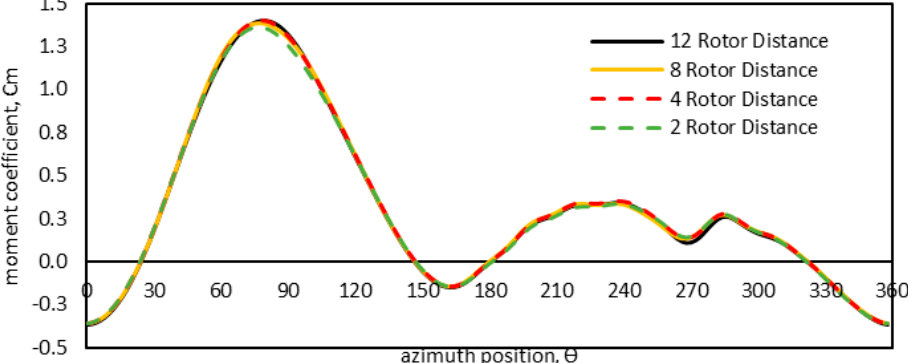
Figure 15. Torque ripple of center turbines at different turbine distances.